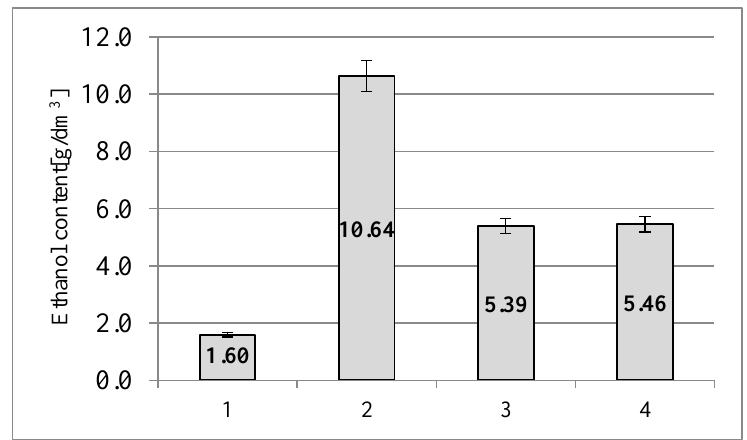
Figure 4. Concentration of ethyl alcohol after 96 h of alcoholic fermentation of triticale straw: 1—control sample; 2—pretreated with ionic liquid; 3—pretreated with white bleach (sulfate method); 4—pretreated with recycled ionic liquid.